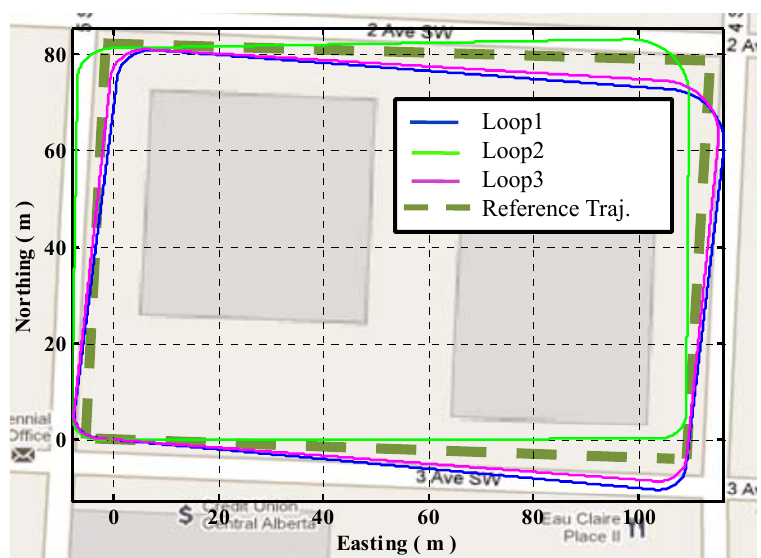
Figure 15. Trajectories obtained using QSF in urban